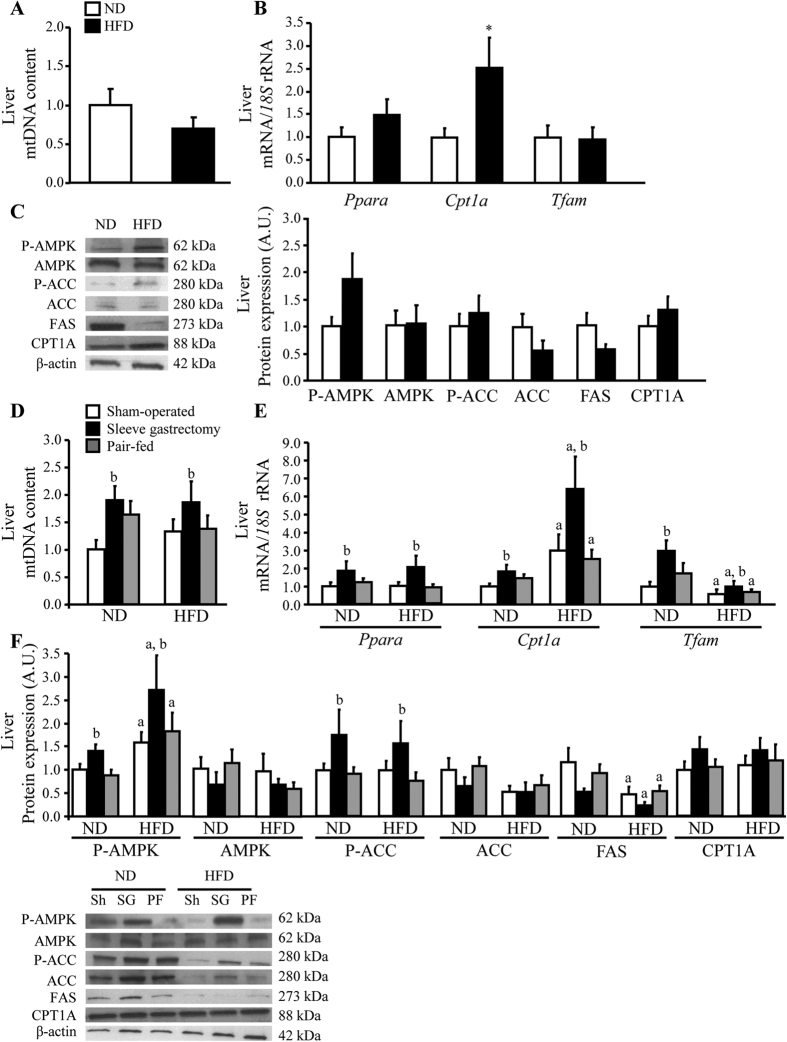
Impact of sleeve gastrectomy on hepatic mitochondrial biogenesis and FFA β-oxidation.Bar graphs show the effect of obesity (A,B) and sleeve gastrectomy (D,E) on the hepatic gene expression of molecules involved in mitochondrial biogenesis (mtDNA content and Tfam) and FFA β-oxidation (Ppara and Cpt1a). Representative cropped blots and Western-blot analysis show the impact of obesity (C) and sleeve gastrectomy (F) on the phosphorylation/activation of AMPK in Thr172 and the phosphorylation/inactivation of ACC in Ser79 as well as the basal expression of AMPK, ACC, FAS and CPT1A enzymes in liver samples of the experimental groups. The gene and protein expression in lean or in the sham group fed a ND was assumed to be 1. *P < 0.05 vs lean control ND; aP < 0.05 effect of diet; bP < 0.05 effect of surgery.